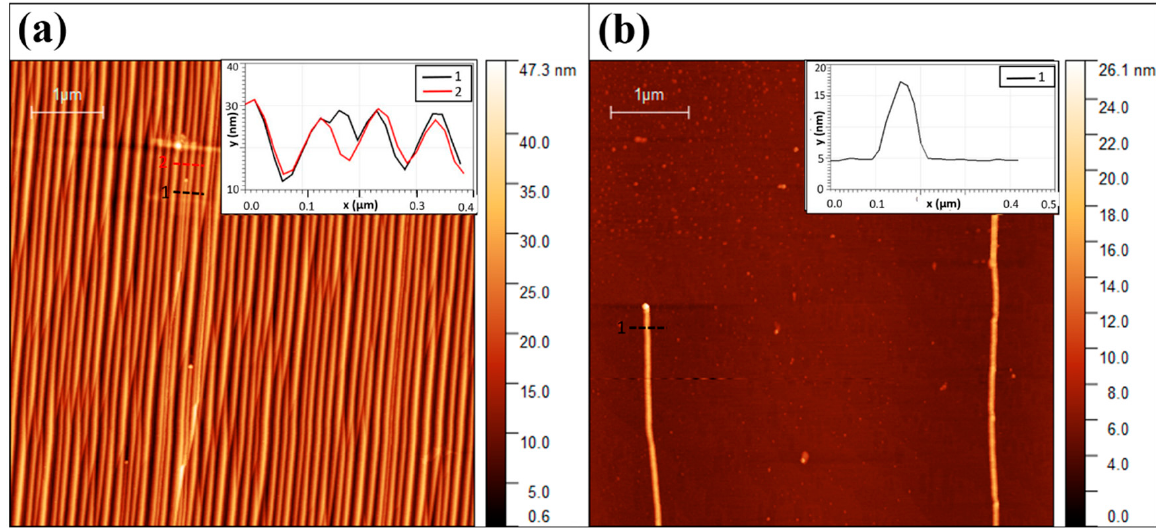
Figure 2. Atomic force microscopeimages of surface-guided GaN NWs grown on ( a ) the faceted annealed M-plane sapphire substrate and on ( b ) the flat R-plane sapphire substrate. Scale bar in both images is equal to 1 µm. The insets represent the height cross-sections of the NWs.